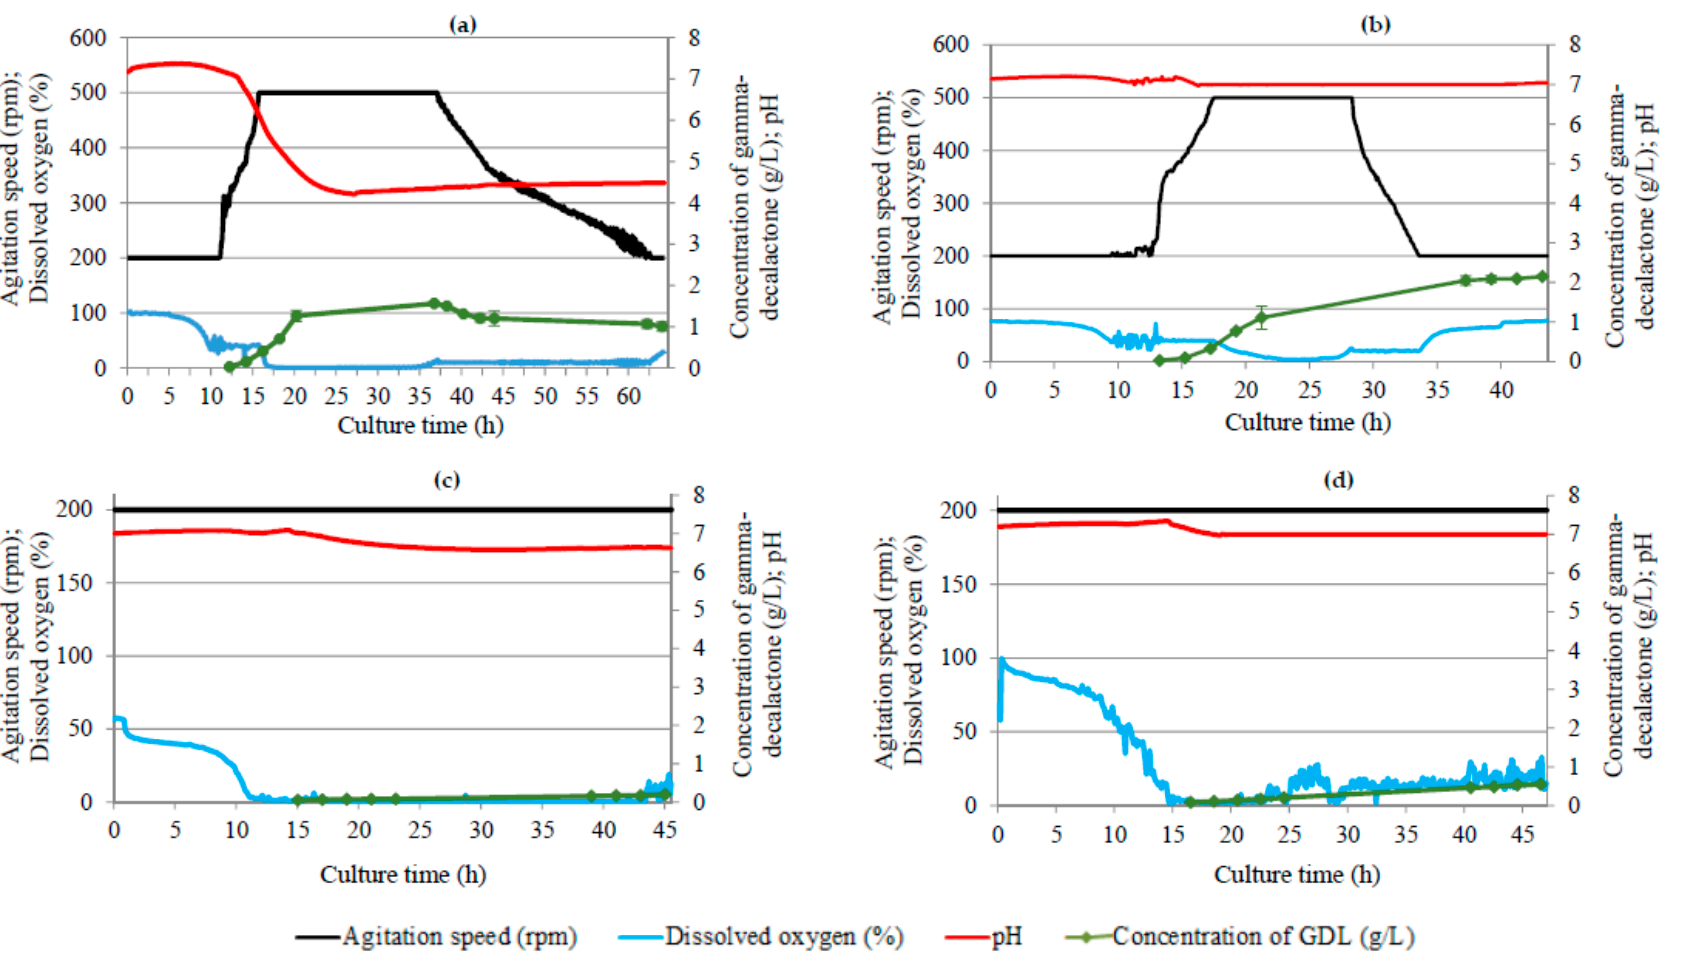
Figure 1. Changes in dissolved oxygen, agitation speed, and concentration of γ -decalactone in the batch cultures of Y. lipolytica yeast carried out in accordance with L4 orthogonal array. Batch culture parameters: ( a ) bioreactor culture 1—agitation speed of 200–500 rpm, unregulated pH, castor oil concentration of 75 g/L; ( b ) bioreactor culture 2—agitation speed of 200–500 rpm, regulated pH, castor oil concentration of 50 g/L; ( c ) bioreactor culture 3—agitation speed of 200 rpm, regulated pH, castor oil concentration of 50 g/L; ( d ) bioreactor culture 4—agitation speed of 200 rpm, regulated pH, castor oil concentration of 75 g/L.